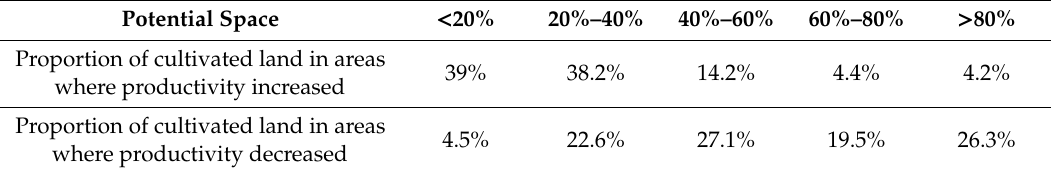
Table 2. Statistics of the potential space of single cropping system in productivity changed